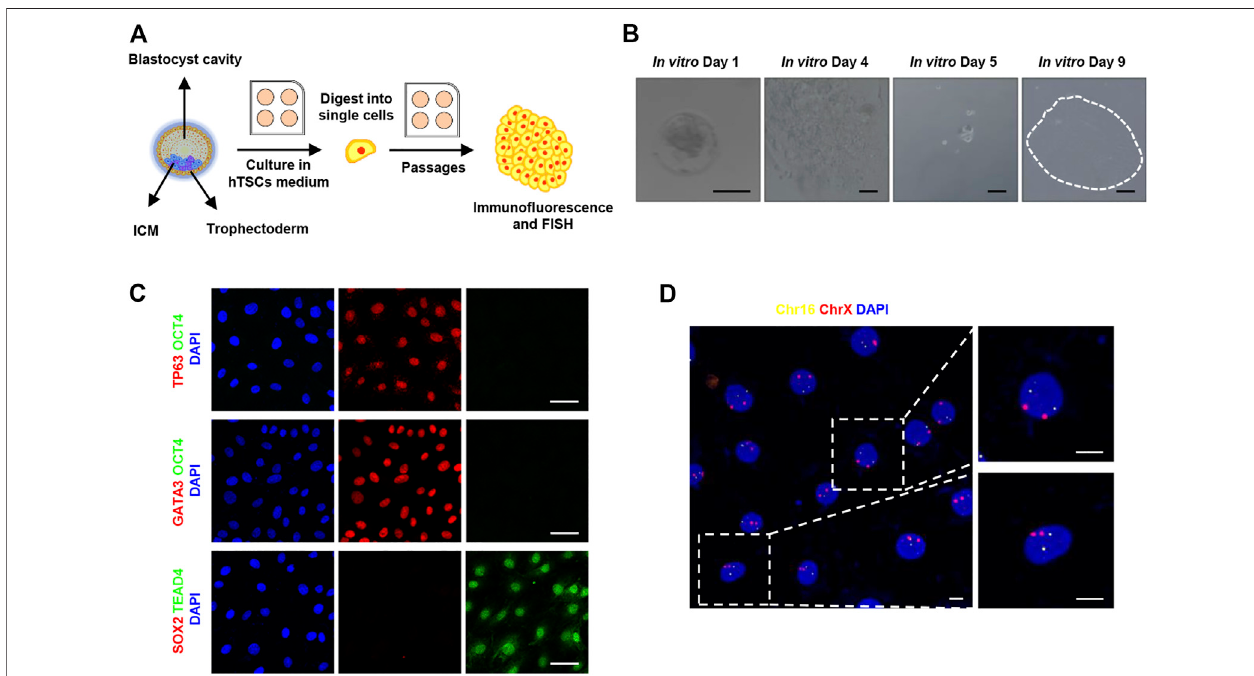
FIGURE 1 | Derivation of human trophoblast stem cells. (A) Cartoon depicting the strategy of derivation of human trophoblast stem cells from blastocysts. ICM, inner cell mass; hTSCs, human trophoblast stem cells; FISH, fl uorescence in situ hybridization. (B) Bright- fi eld images showing a human blastocyst and proliferative trophoblast cells. Images from left to right are: Human blastocysts (day 6) were thawed (designated as in vitro cultured day 1) and cultured in hTSCs culture medium; humanembryosattachedtotheplates;theattachedembryosweredigestedintosinglecells;thesinglecellscontinuedtogrowandformedacellclone. Dottedline showsacellcolony.Scalebars,100 μ m. (C) ImmunostainingofhTSCs.Markersoftrophoblastcells:TP63,TEAD4,andGATA3;markersofembryonicstemcells:OCT4 andSOX2.DAPI,blue,DNA.Scalebars,50 μ m. (D) Fluorescence insitu hybridizationofchromosomes16andXinhTSCs.Chr16,chromosome16,ChrX,chromosome X. DAPI, blue, DNA. Scale bars, 10 μ